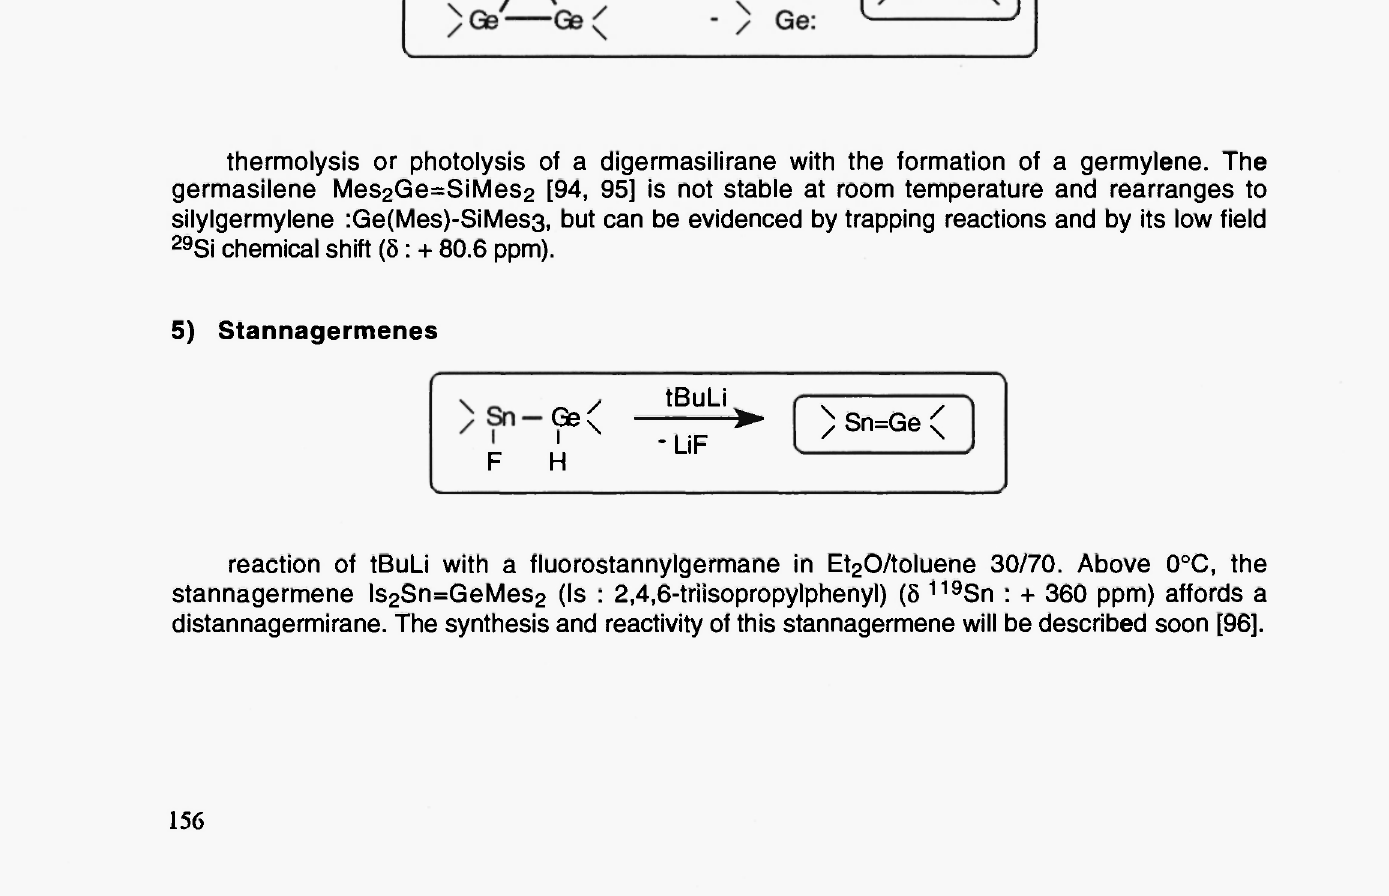
synthetic routes